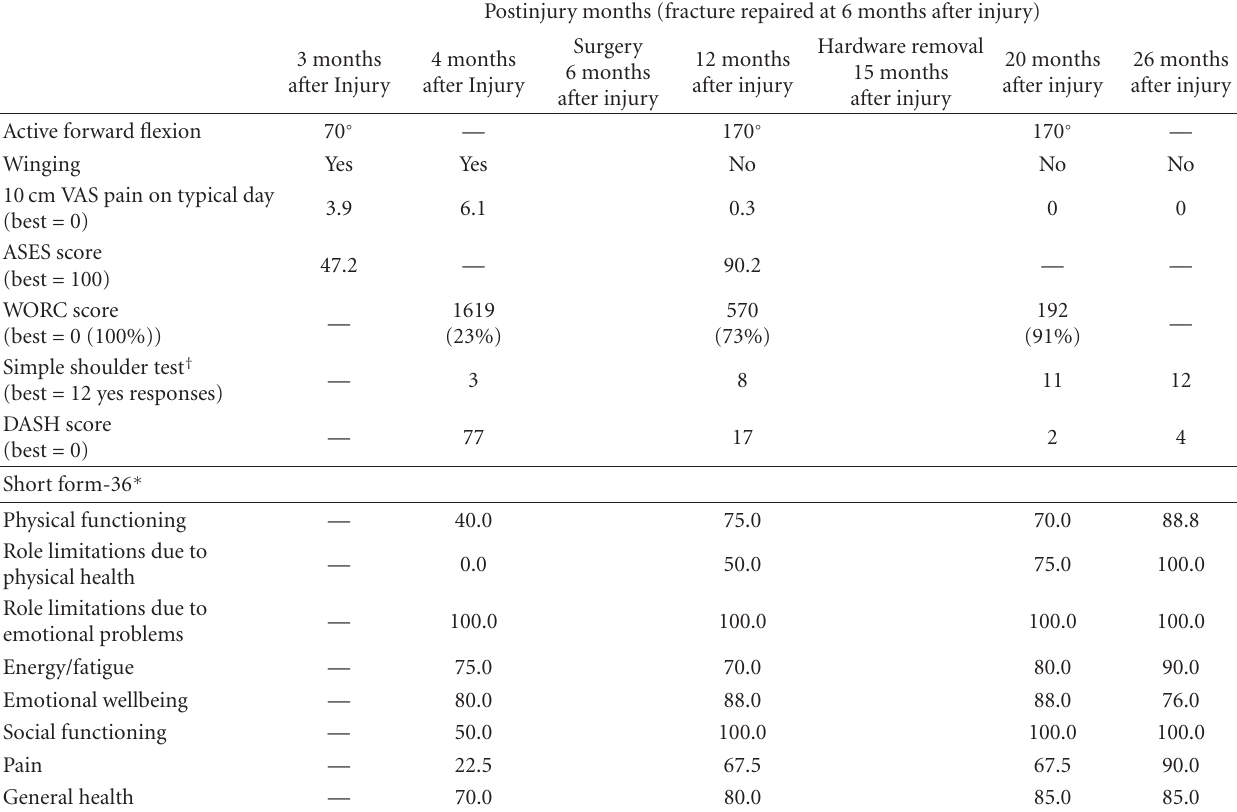
Table 1: Outcome scores and physical examination data: visual analog scale (VAS) for pain, Western Ontario rotator cu ff index (WORC), the American shoulder and elbow surgeons standardized shoulder assessment form (ASES), simple shoulder test (SST), disabilities of the arm, shoulder and hand (DASH) score, short form 36 (SF-36), and shoulder range of motion (ROM)